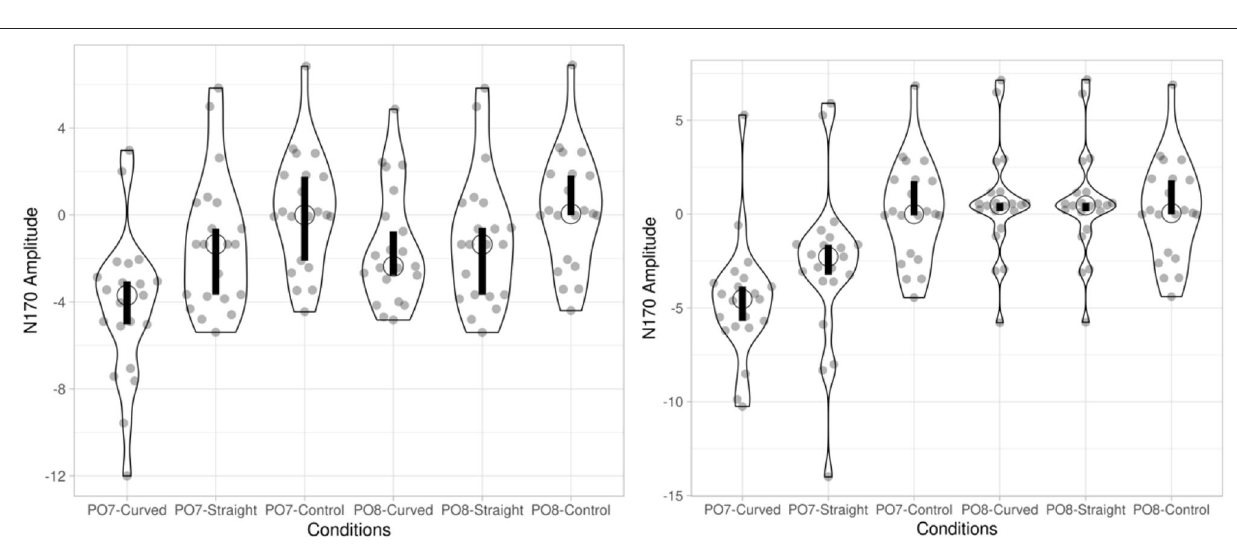
hemisphere (PO8) for curved-line drawing followed by English recognition [ F (1, 40) = 30.79, p < 0.001, η 2 = 0.44], but laterality effects were not significant in the straight-line drawing condition and control condition ( p <